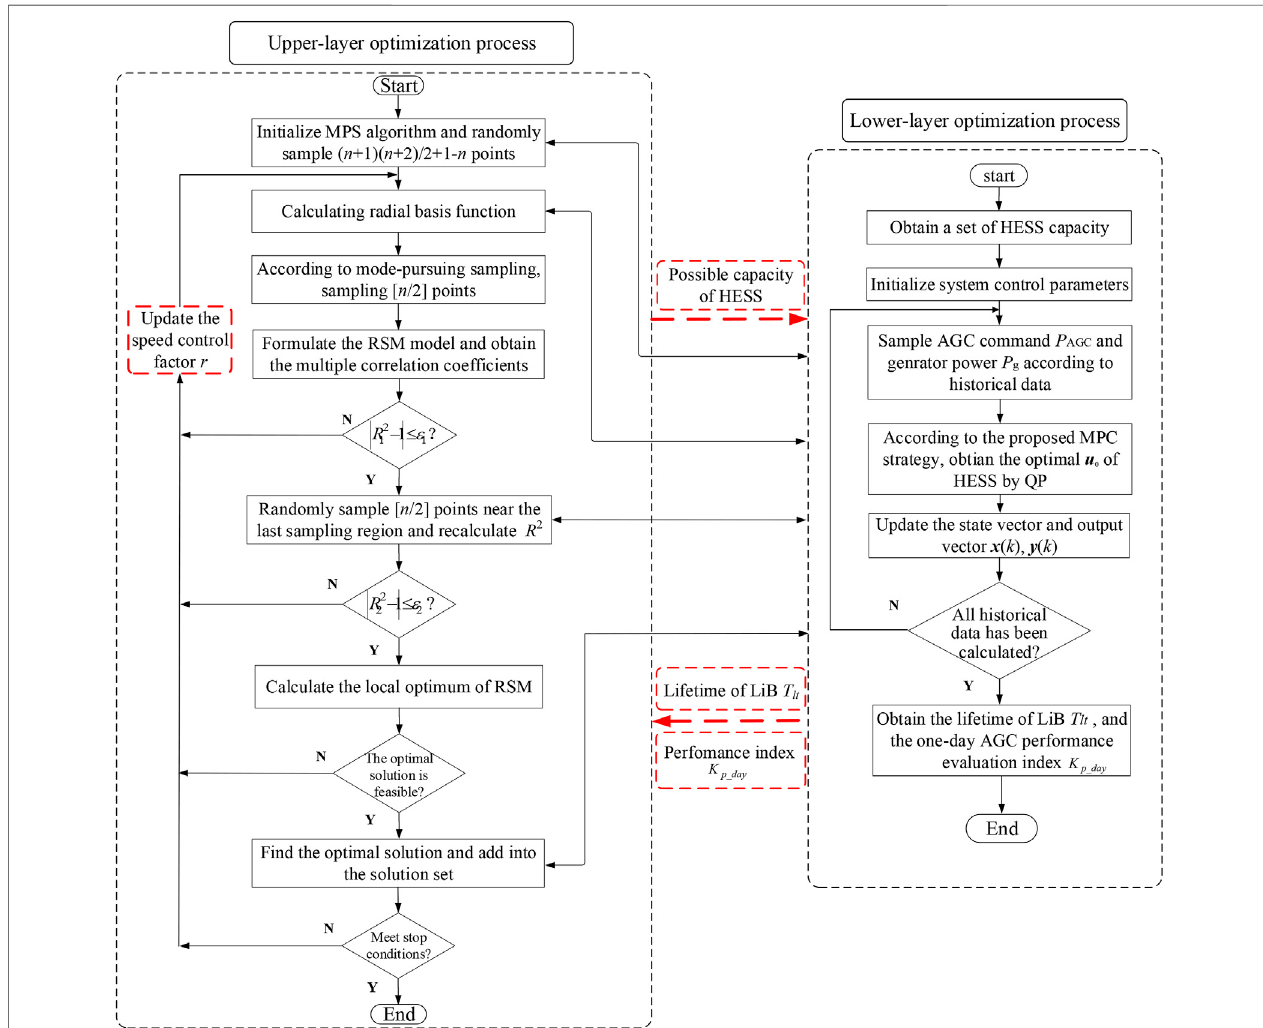
FIGURE 3 | The fl ow diagram of the proposed bi-layer capacity con fi guration